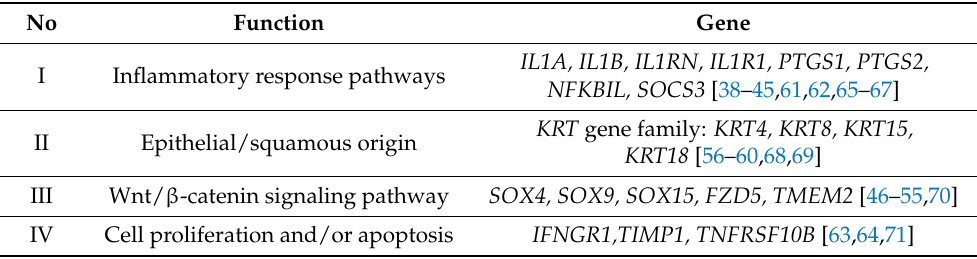
Table 3. Genes selected based on the literature and further evaluated with the GSE1420 database, gathered in main functional